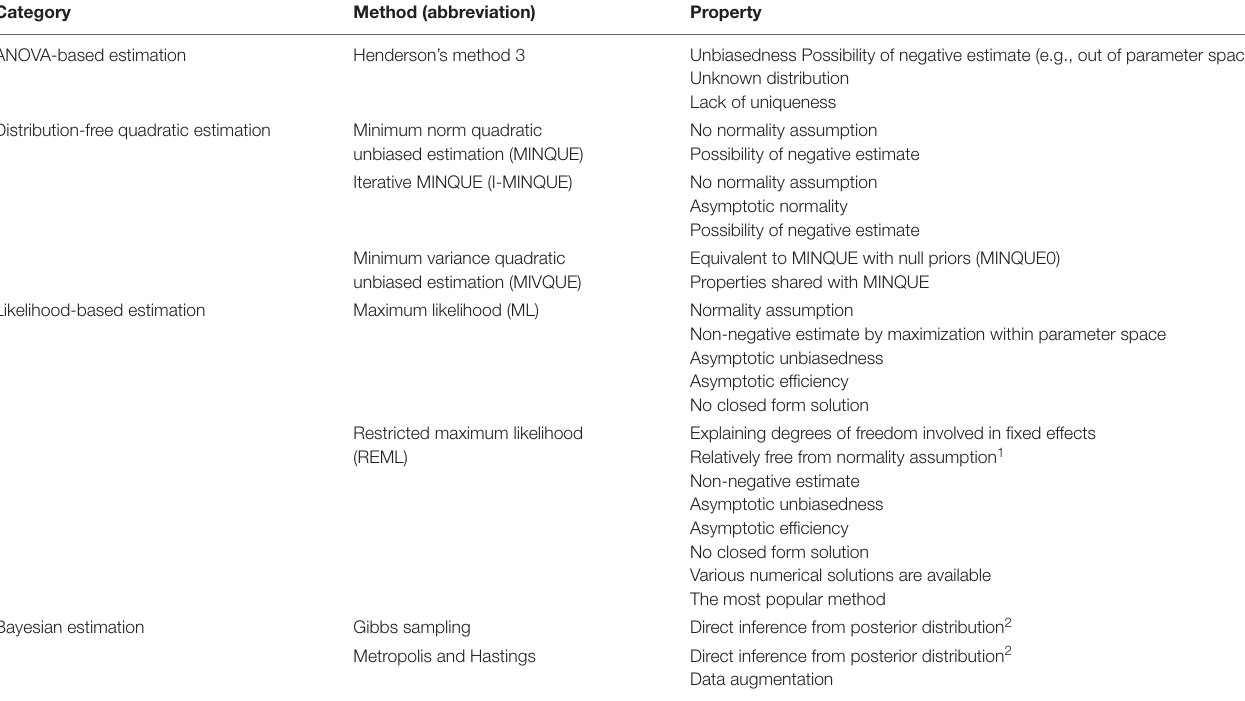
TABLE 1 | Major methods for variance component estimation in a mixed model